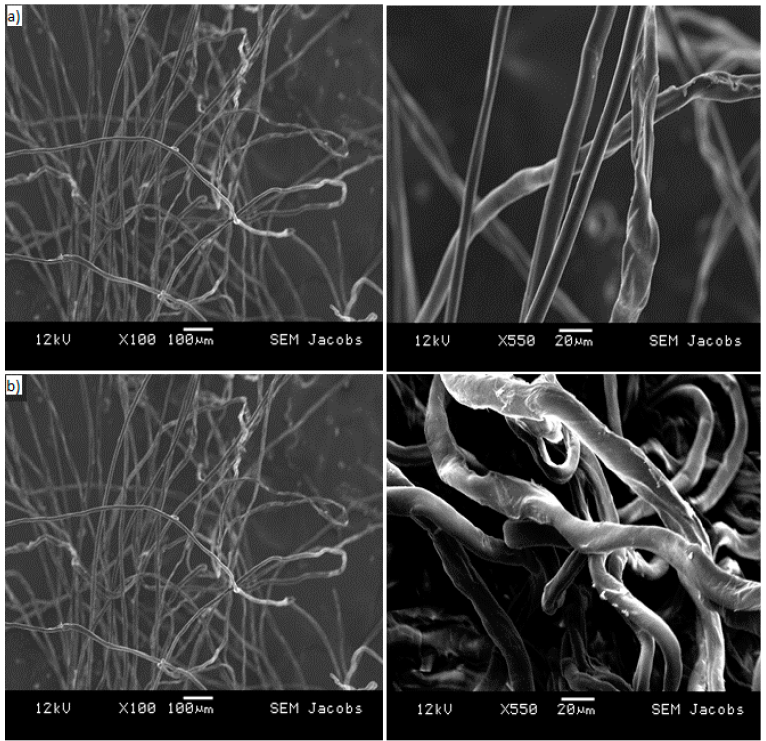
Figure 1. SEM images of ( a ) virgin cellulose fibers and ( b ) adsorptive Q fibers at different